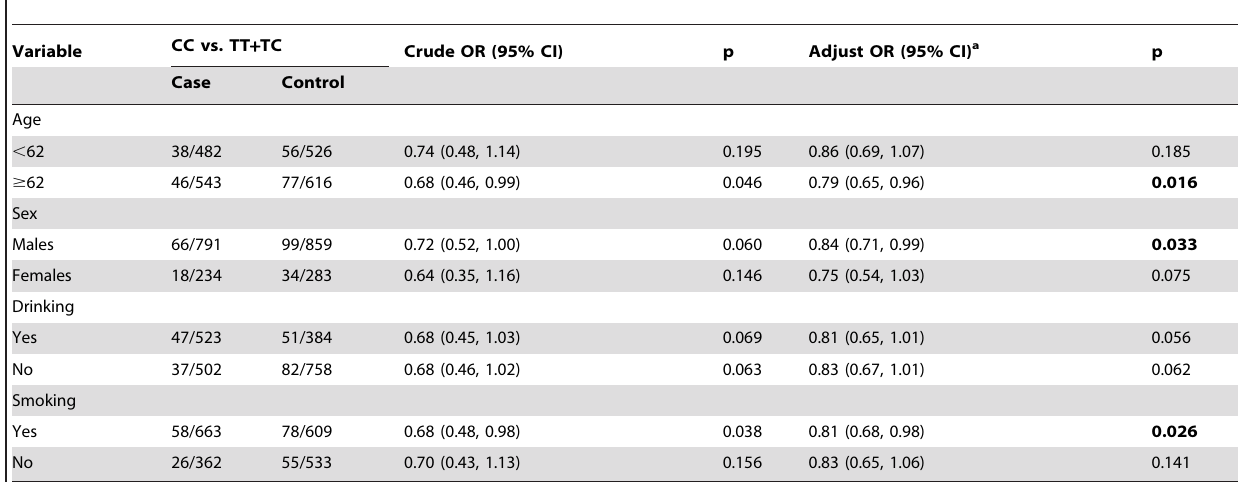
Table 5. Stratified results for pri-miR-34b/c rs4938723 T . C by age, sex, drinking and smoking.